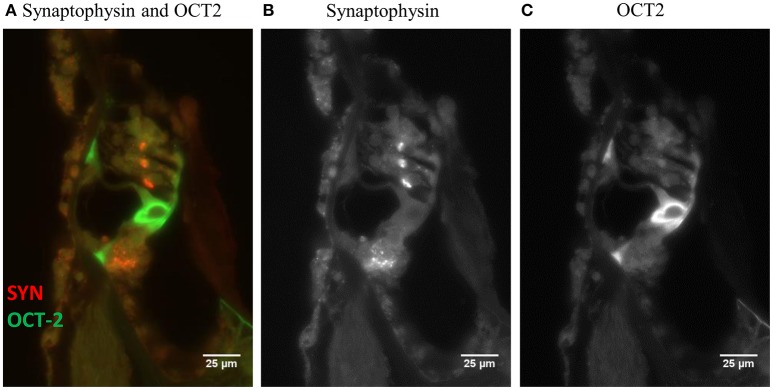
(A) A fluorescent image (40 X) of the organ of Corti from a normal guinea pig. The orange and green labeling indicates immunoreactivity of synaptophysin and OCT2. In order to perform a quantification using densitometry measuring, the software converts the colors to a gray scale, (B) synaptophysin and (C) OCT2, (CTR1 image not shown). Scale bar: 25 μm.